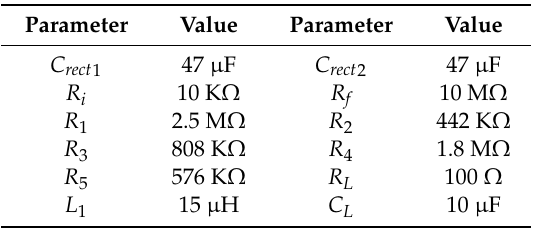
Table 3. Parameters of the entire circuit system.